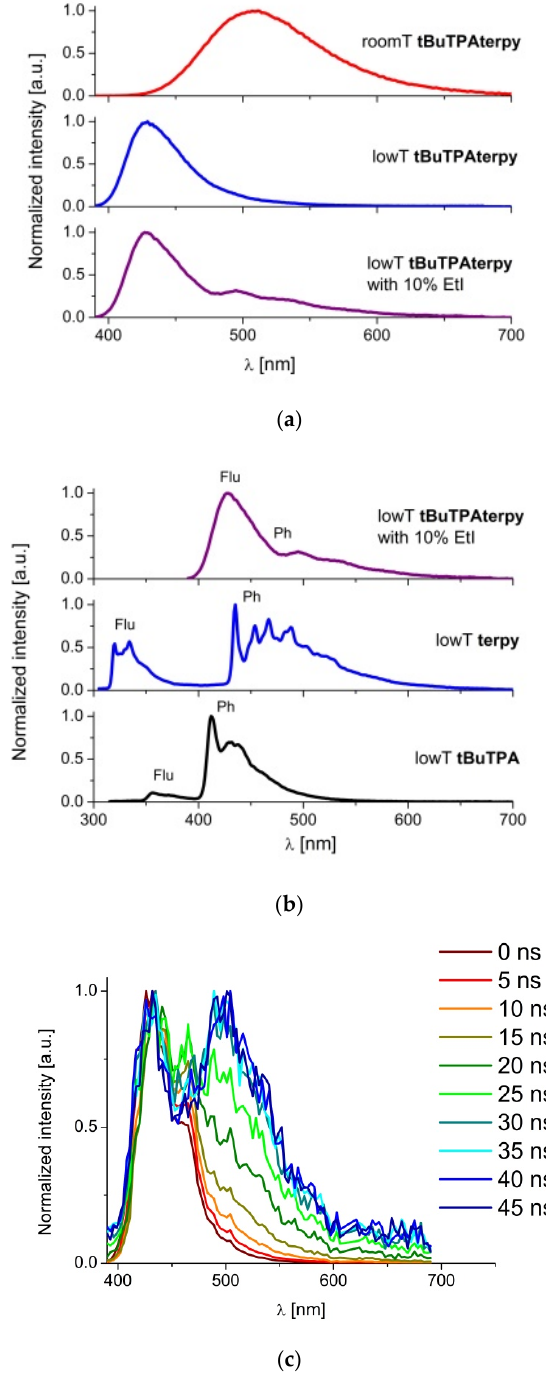
Figure 7. ( a ) Comparison of the normalized steady-state emission spectra of tBuTPAterpy at room temperature (red), 77 K (blue) and 77 K after addition of 10% of ethyl iodide to the solution (purple) (c = 10 µ M; λ PE = 375 nm); ( b ) Comparison of the steady-state emission spectra of tBuTPAterpy at 77 K with a 10% addition of ethyl iodide (purple), 77 K emission spectra of terpy (blue) and tBuTPA (black) (c = 10 µ M; λ PE = 375 nm); ( c ) Normalized TRES traces of tBuTPAterpy in BuCN at 77 K ( λ PE = 375 nm; emission slit: 1 nm; detector signal: 7000 cps, wavelength step: 3 nm, stop conditions: 300